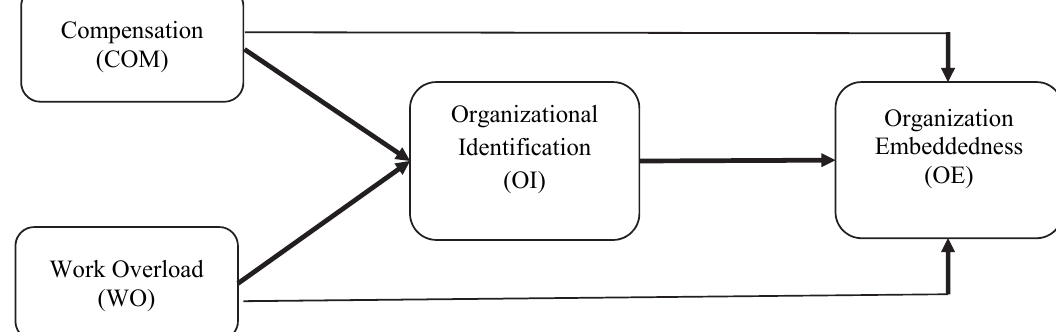
Fig. 1. Research Framework